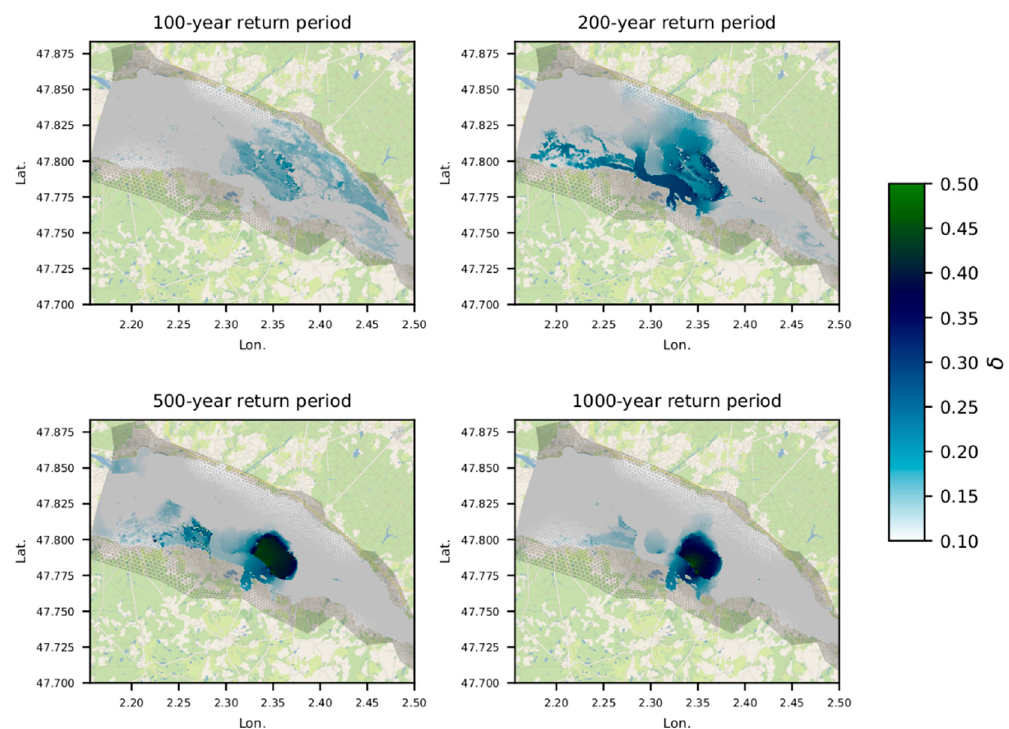
Figure 6. Borgonovo indices for Saint-Père breach width for 100, 200, 500 and 1000-year return period flood events.